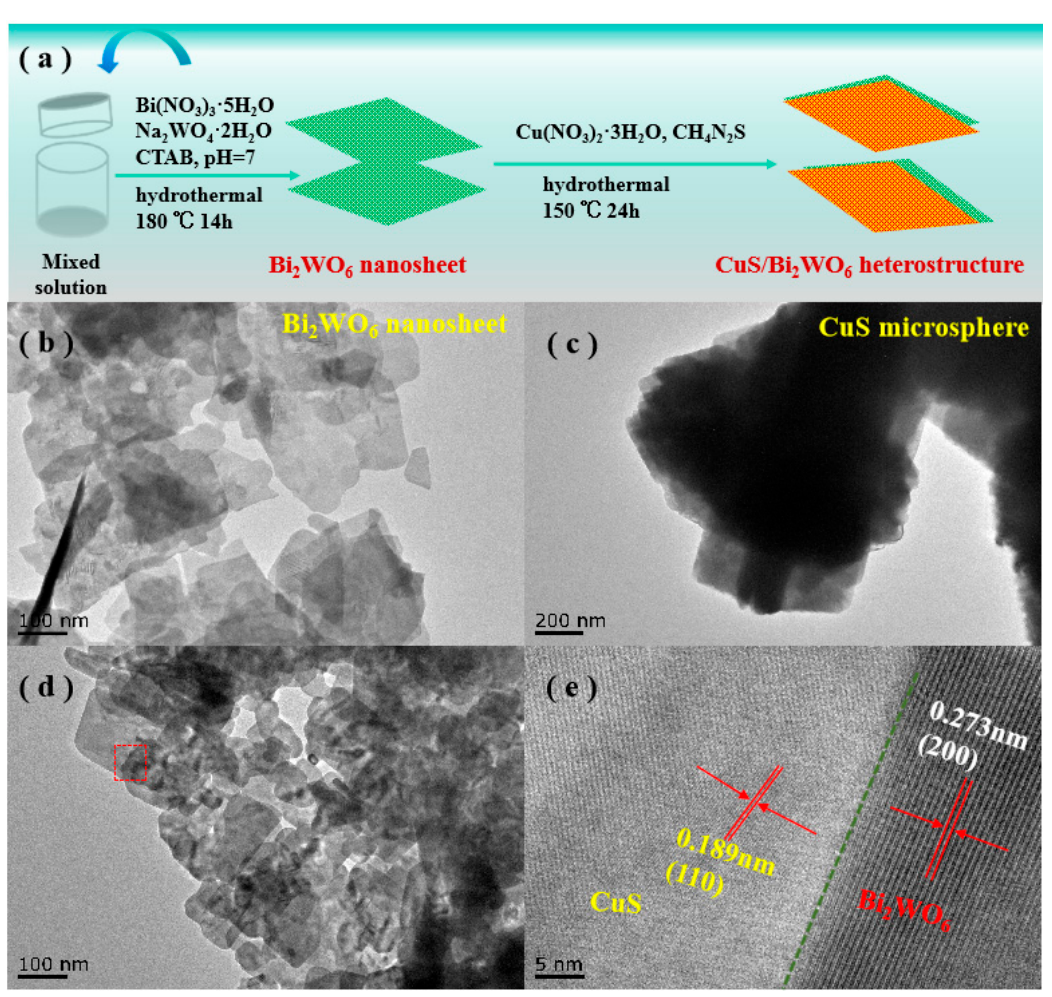
Figure 4. ( a ) Schematic preparation of CuS/Bi 2 WO 6 sheet-onto-sheet p-n heterostructures. ( b ) TEM images of Bi 2 WO 6 . ( c ) TEM images of CuS. ( d ) TEM and ( e ) HRTEM image of as-prepared 2D/2D 0.1% CuS/Bi 2 WO 6 sheet-onto-sheet heterostructure.